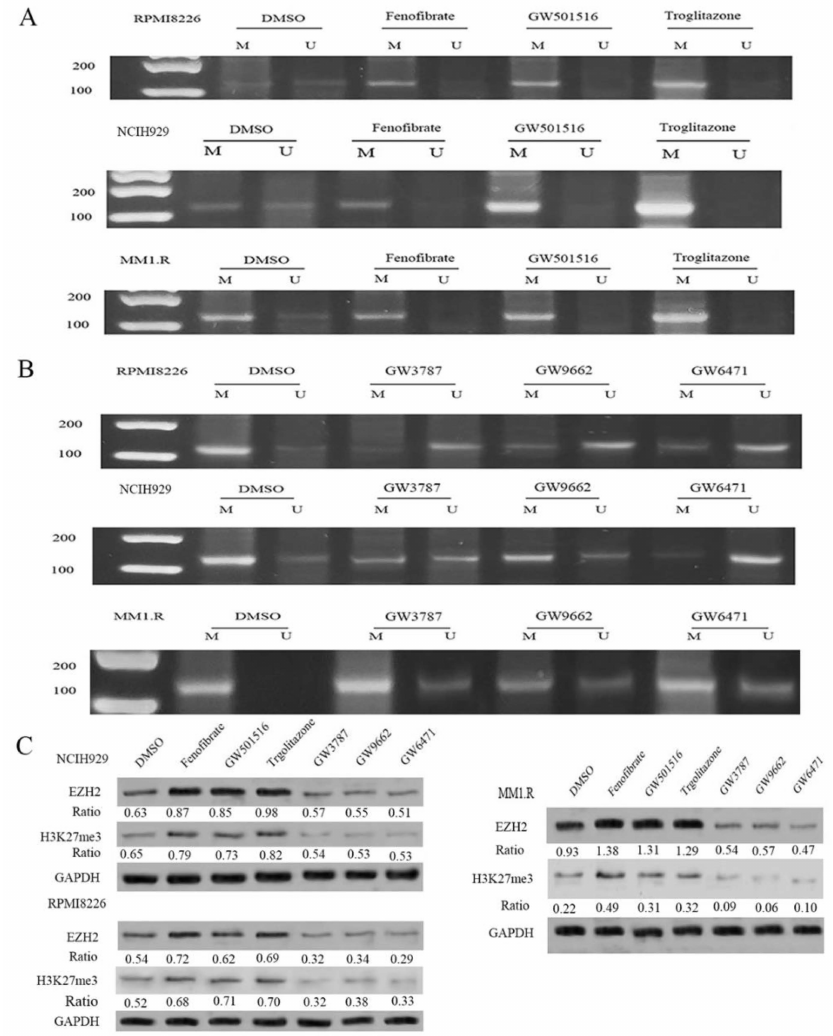
Figure 2. PPAR agonists or antagonists affect the methylation pattern of CpG island in CRBN pro- moter region. ( A , B ) RPMI8226, NCIH929 and MM1.R cells were treated with 5 µ M PPAR agonists (Fenofibrate, GW501516, and Troglitazone) or 10 µ M PPAR antagonists (GW3787, GW9662, and GW6471) 48 h. MSP shows the different pattern of methylation status. M: results of methylation specific PCR amplification. U: results of non-methylation specific PCR amplification; ( C ) RPMI8226, NCIH929 and MM1.R cells were treated with 5 µ M PPAR agonists (Fenofibrate, GW501516, and Trogli- tazone) or 10 µ M PPAR antagonists (GW3787, GW9662, and GW6471) 48 h. EZH2 and H3K27me3 expression were measured by Western blot. The intensity of the level of EZH2, H3K27m23 and GAPDH was quantitated and the ratio of EZH2/H3K27m3 vs. GAPDH was indicatd. The uncropped blots are shown in Figure